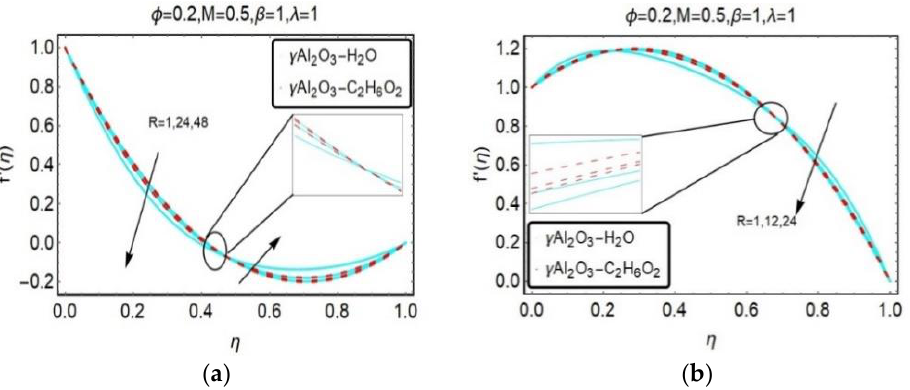
Figure 7. Influence of 𝑅 on 𝑓′(𝜂) for ( a ) 𝑆 > 0 and ( b ) 𝑆 < 0 .